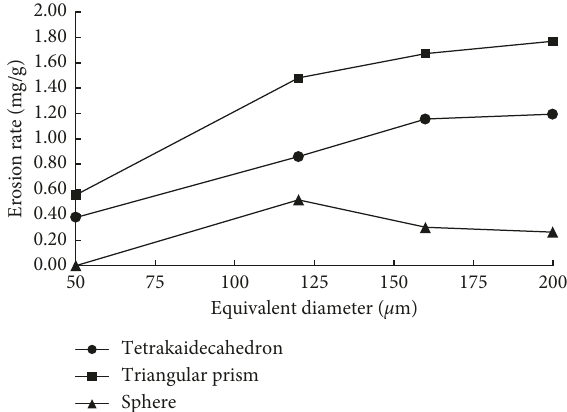
Figure 16: Effect of particle diameters on the erosion rate.